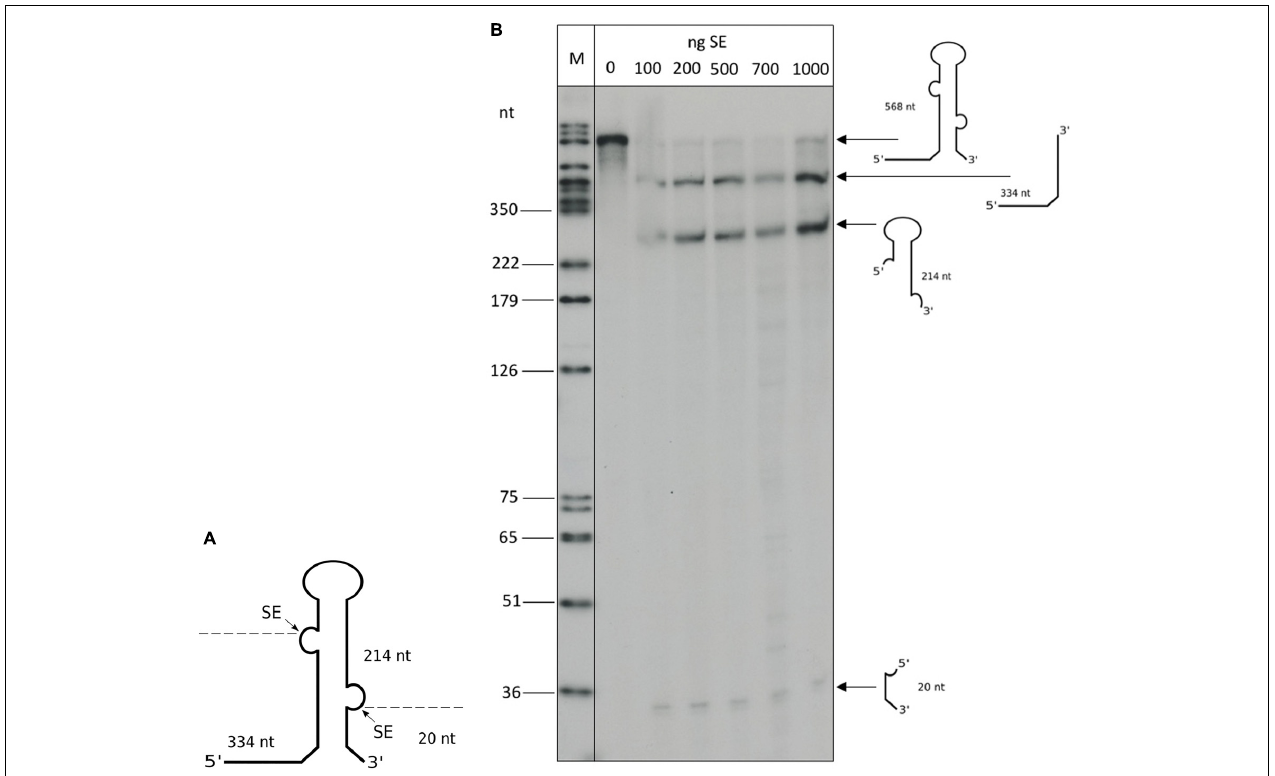
FIGURE 9 | In vitro processing of a truncated 16S precursor. (A) Schematic drawing of the truncated 16S rRNA precursor used for the in vitro reaction: 1,450 nucleotides of the internal part of the 16S rRNA were deleted. Arrows and dashed lines indicate the SE splice sites and processing products. The resulting fragment sizes are given in nucleotides. (B) In vitro processing was performed with recombinant SE and the radioactively labeled substrate. Different amounts of SE protein were used (between 100 and 1,000 ng), as indicated at the top of the lanes. A DNA size marker is given on the left. The 568 nt long precursor is processed by the SE, resulting in three fragments: a 334 nt leader fragment, a 214 nt 16S rRNA loop fragment and a 20 nt trailer fragment. SE processing products can be observed beginning at 100 ng. Processing fragments are shown schematically on the